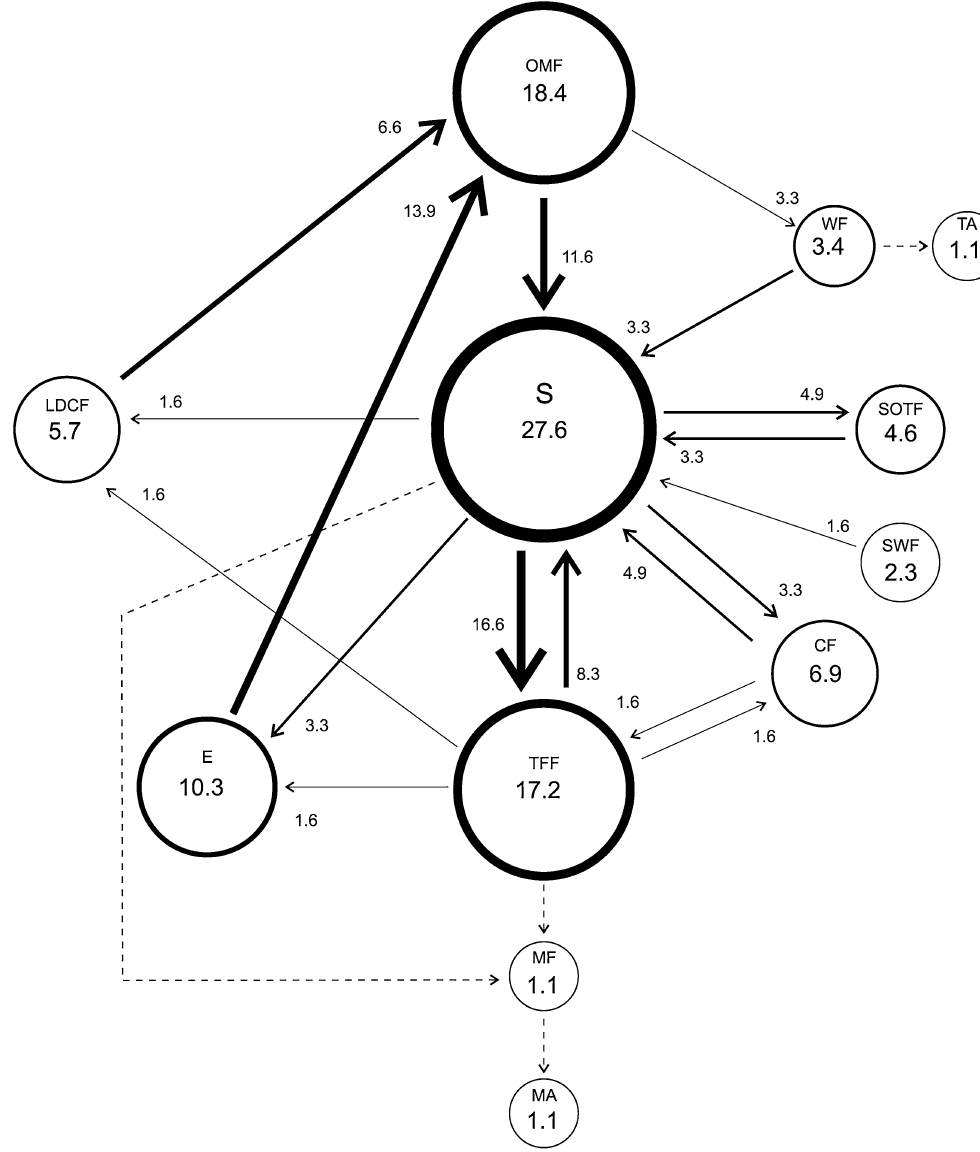
Figure 5. Courtship behavior of Anastrepha curvicauda dominant 7–8 days old males caged with a 5–7 d old virgin female and a subordinated male. Choice experiment. Circle size and line thickness are proportional to their percentage values. Dotted lines represent transitions with a median < 1. See Table 1 for